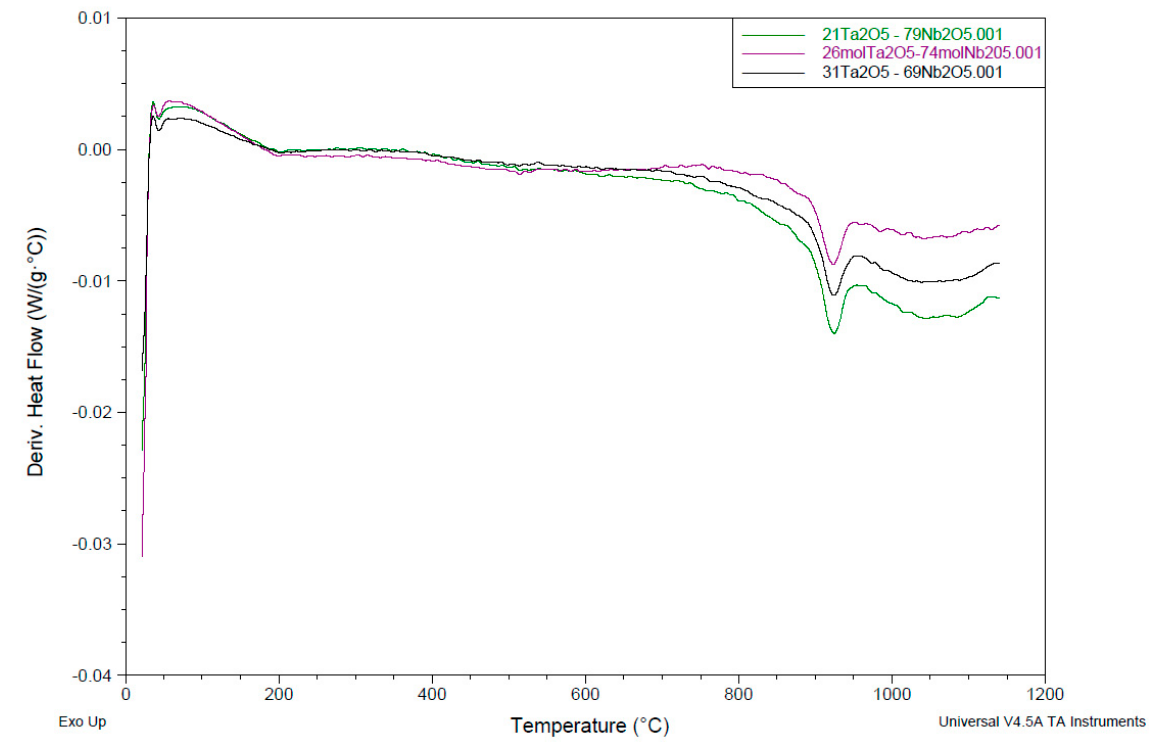
Figure 1. DSC scans of three Ta 2 O 5 -Nb 2 O 5 compositions (green: 21 Ta 2 O 5 to 79 Nb 2 O 5 ; violet: 31 Ta 2 O 5 to 69 Nb 2 O 5 ; grey: 26 Ta 2 O 5 to 74 Nb 2 O 5 ; all concentrations are in mol%).